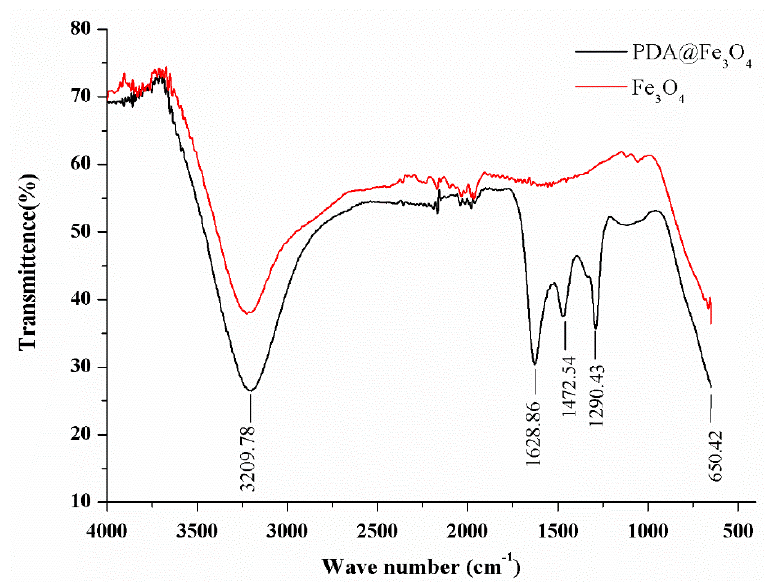
Figure 4. Comparative FTIR of naked Fe 3 O 4 and polydopamine coated Fe 3 O 4 nanoparticles.